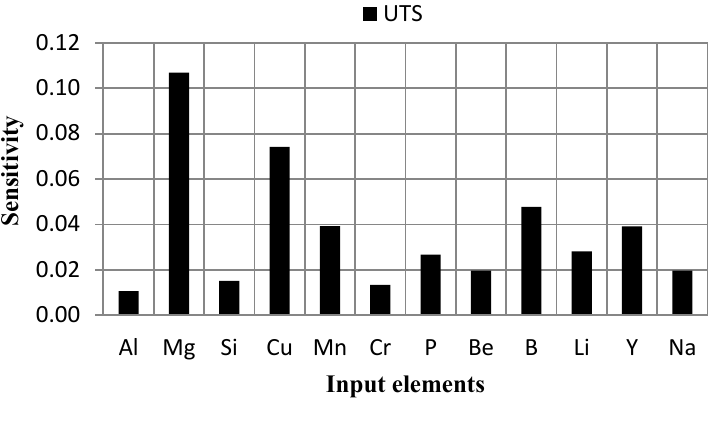
Figure 3. The sensitivity of input